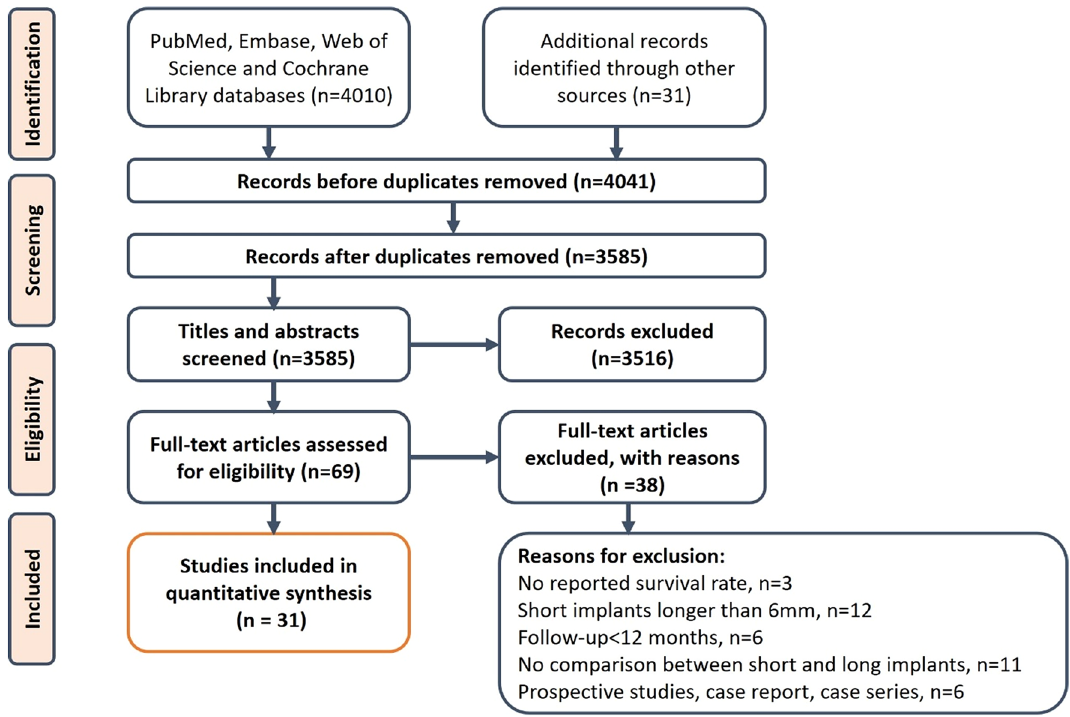
Figure 1. PRISMA flowchart of the screening Publication bias. Funnel plots displayed the publication bias calculated by Egger test (Supplementary Fig-